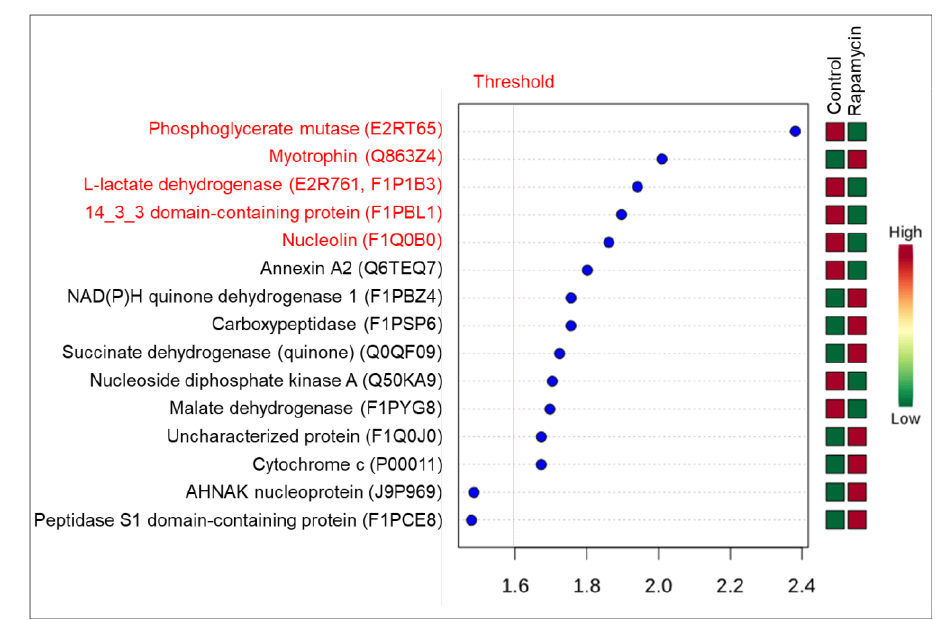
Figure 4. VIP score from PLS-DA of the control (non-treated versus treated with rapamycin). Colored boxes indicate protein abundance in each group (control and rapamycin treatment). Threshold considered for VIP score was α > 1.6. All proteins were observed in the T test and Volcano plot (FRD < 0.05). Proteins highlighted in red color were the main proteins in all analysis.